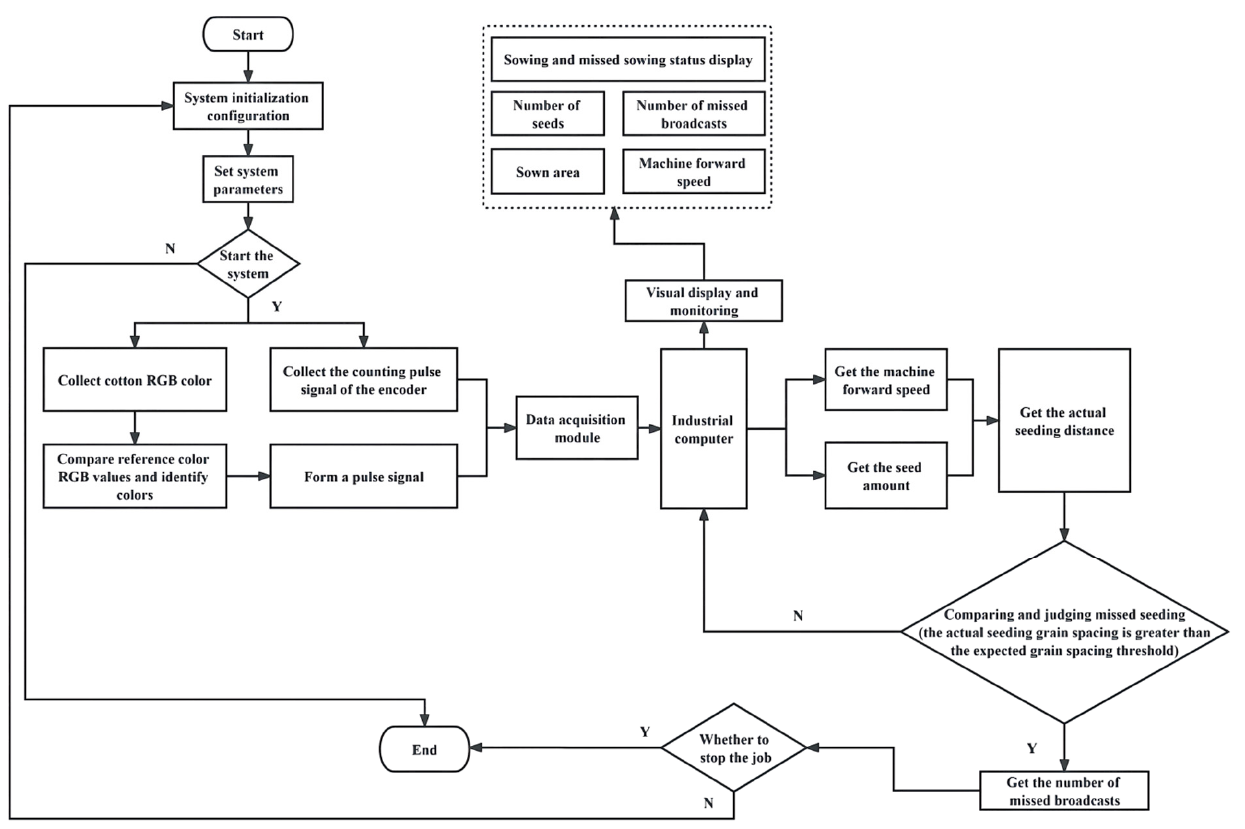
Figure 5. Program flow diagram of software system.